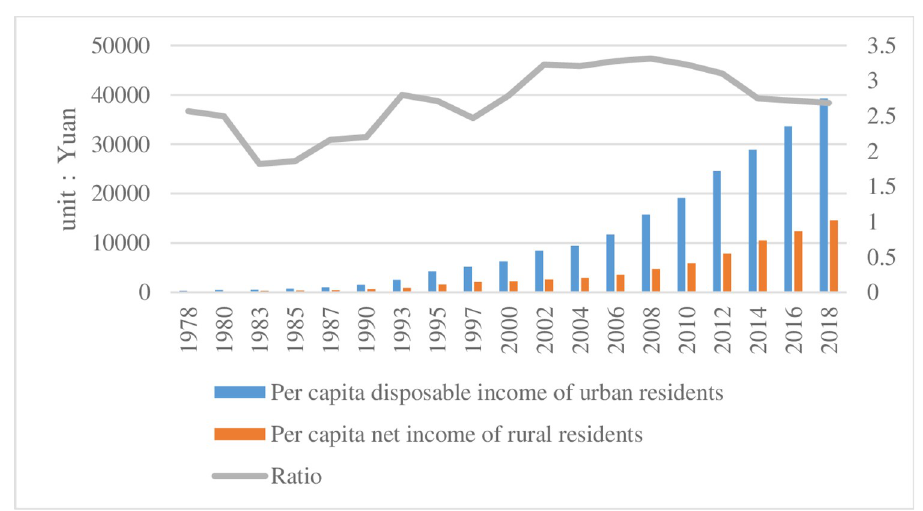
Fig 1. Change in income of urban and rural residents since the reform and opening-up of China.